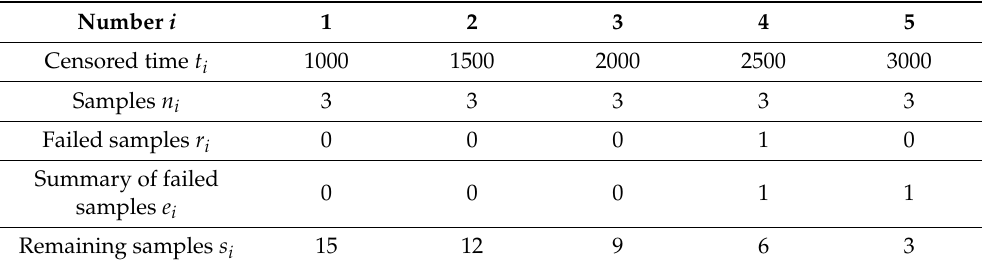
Table 3. Sun Gear Test Data.